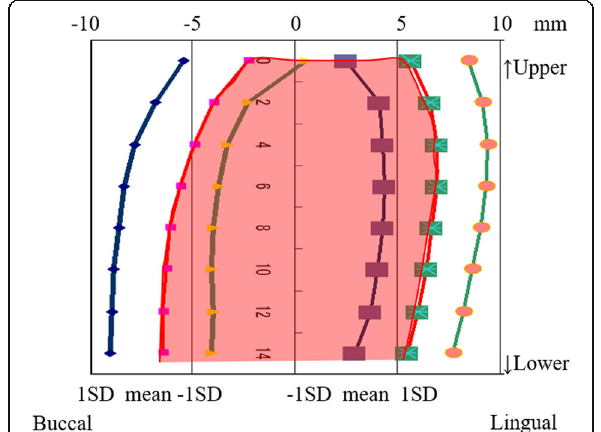
Fig. 3 The average shape of the mandibular bone in the first molar region